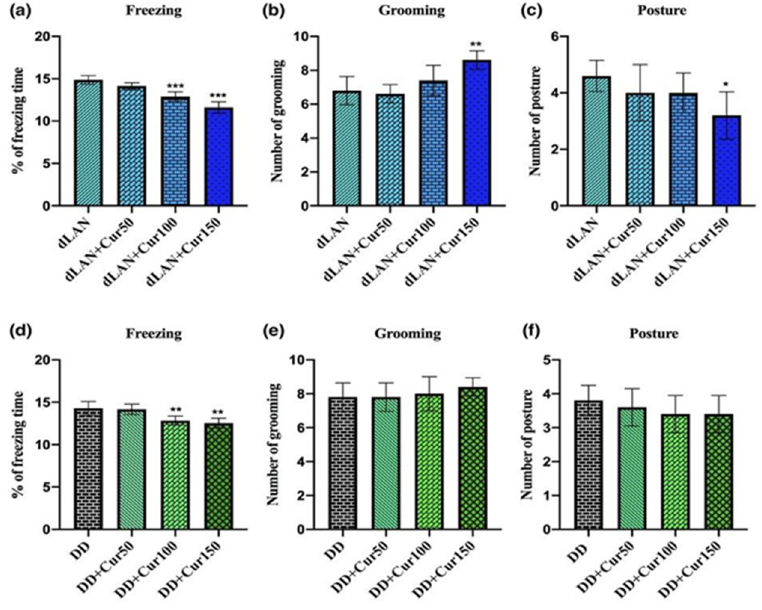
Figure 4. Effect of different concentrations (50, 100, and 150 mg/kg) of orally administered curcumin on anxiety-like behavior of mice. ( a ) Percentage of freezing time in dim light at night (dLAN), ( b ) grooming in dLAN, ( c ) posture in dLAN, ( d ) percentage of freezing time in complete darkness (DD), ( e ) grooming in DD, and ( f ) posture in DD-exposed mice. Values are represented as mean ± standard deviation ( n = 5). Non-parametric one-way ANOVA with post-hoc Dunnett’s test was employed to match the results among different treatment groups. All the data were analyzed with GraphPad Prism-8 software. The statistical values * p < 0.05, ** p < 0.01, and *** p < 0.001 represent a significant difference among the